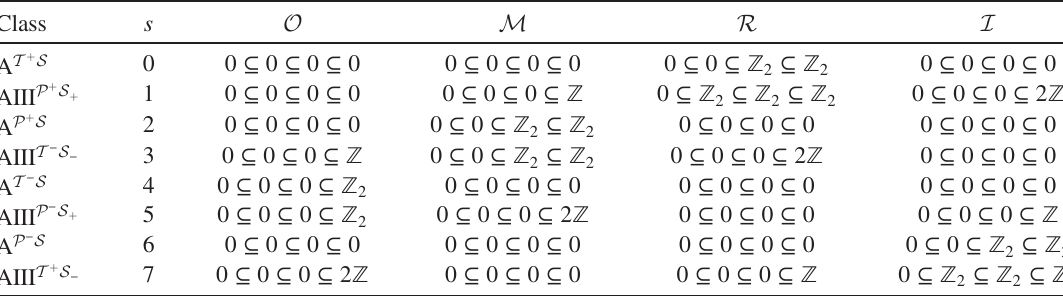
TABLE VI. Same as Table V, but for antiunitary (anti)symmetries.